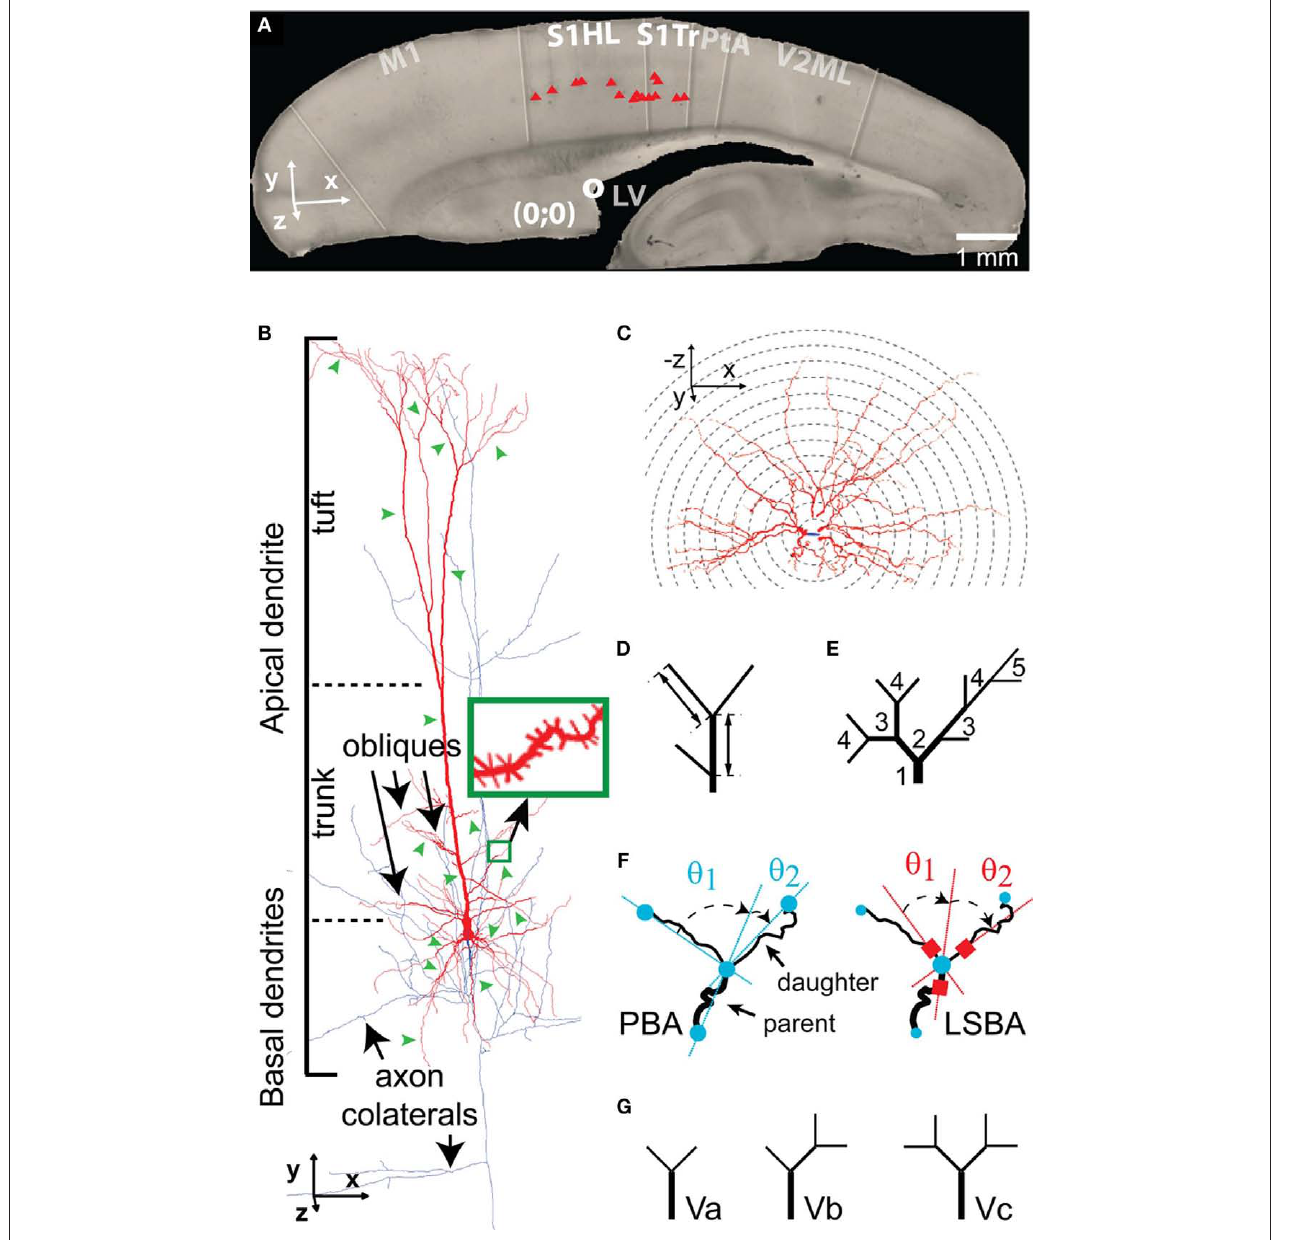
frequency of branching, one order increases following each branch point starting from a stem segment (i.e., the first order segment emerged from the soma or the apical trunk). (F) Branch angles formed between a parent segment and daughter segments. Planar Branch Angle (PBA, Left Panel): angles formed between the distal extending portion of a line passing through the beginning and the ending of a parent segment and the lines passing through the beginning and endings of daughter segments. Local Spline Branch Angle (LSBA, Right Panel): angles formed between the distal extending portion of a line passing through the straight segment portion before the branch point and two lines passing through the straight segment portions after the branch point. (g) Vertex analysis. Terminating vertices were classified based on the pattern of branching at vertices. Three vertice patterns were defined: Va, two terminating branches were bifurcated at a branch point;